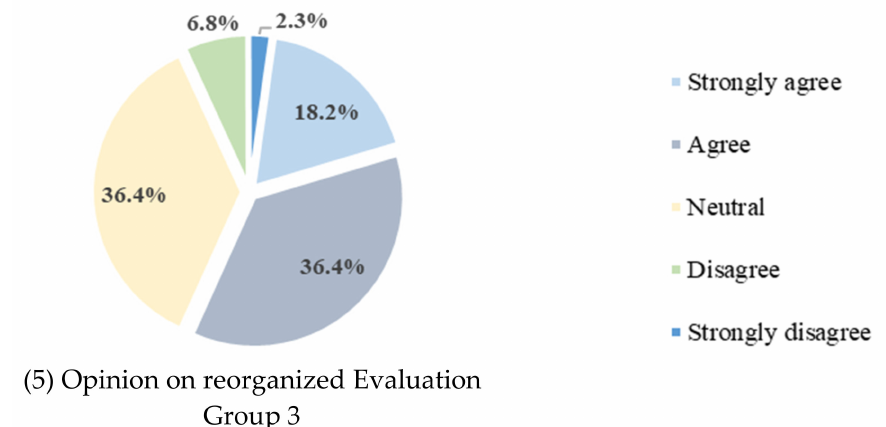
Figure 10. Survey results for evaluation targets and the classification improvement model.